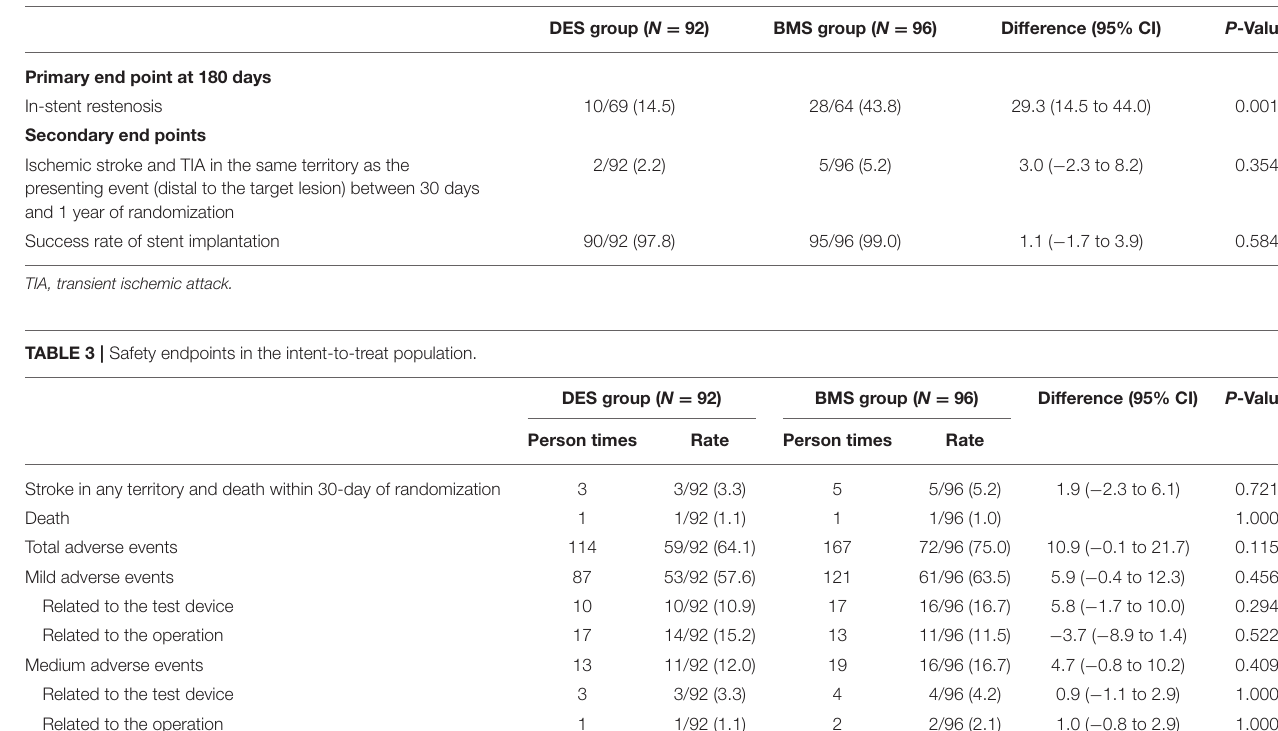
TABLE 2 | Primary and secondary endpoints in the intent-to-treat population.